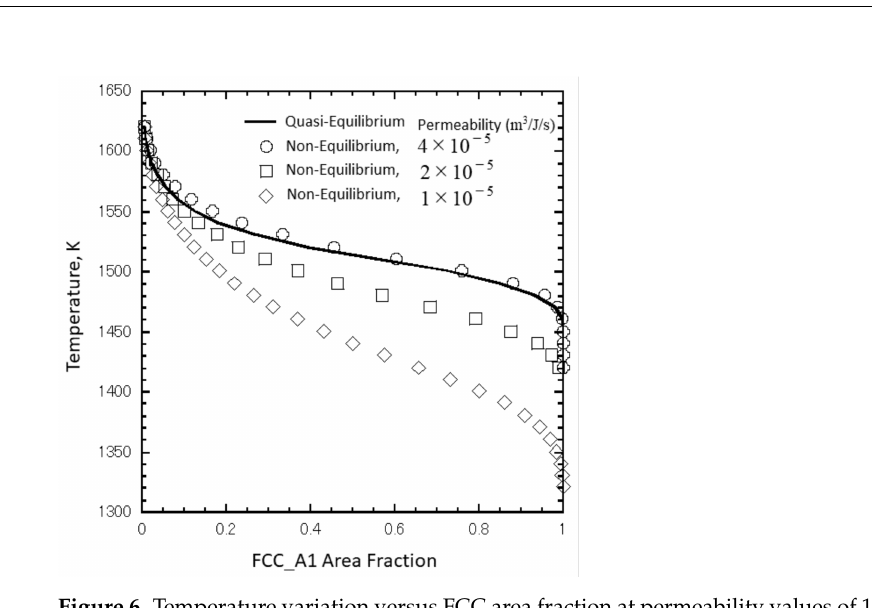
Figure 6. Temperature variation versus FCC area fraction at permeability values of 1 × 10 − 5 m 3 /J/s, 2 × 10 − 5 m 3 /J/s and 4 × 10 − 5 m 3 /J/s at a cooling rate of 10 7 K/s.